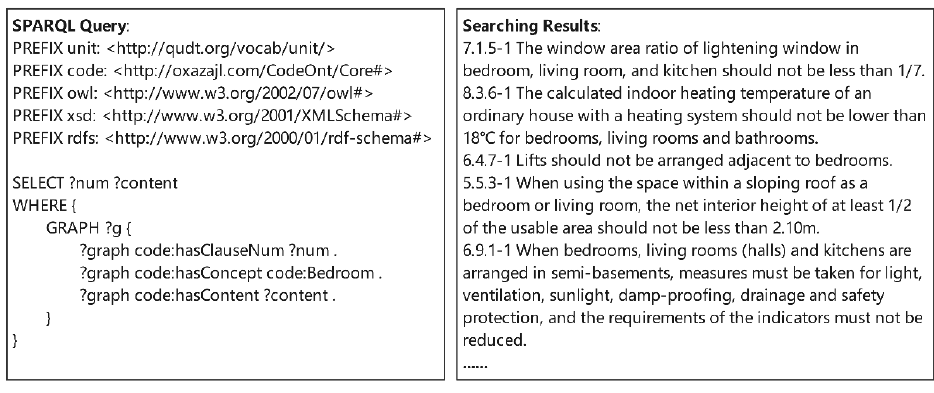
Figure 18. SPARQL query to retrieve the clauses related to bedrooms.